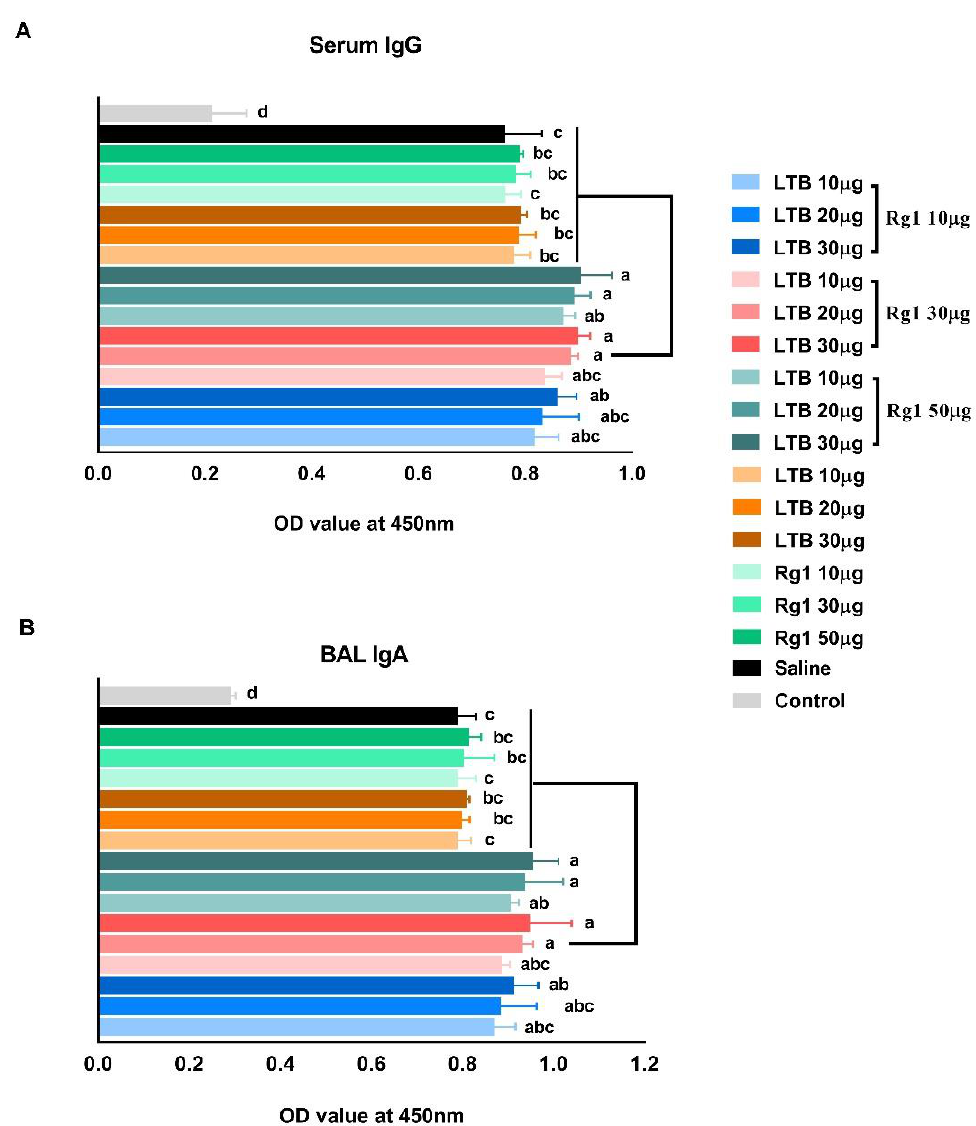
Figure 2. B subunit of Escherichia coli heat-labile enterotoxin (LTB-Rg1) increased porcine reproduc- tive and respiratory syndrome virus (PRRSV)-specific antibody responses. After anesthesia with isoflurane, mice ( n = 6/group) were intranasally immunized with an inactivated PRRSV vaccine (1 × 10 5 TCID 50 ) admixed with saline, LTB alone (10–30 µ g), Rg1 alone (10–50 µ g), or LTB (10–30 µ g) combined with Rg1 (10–50 µ g) on days 0, 7, and 21. Non-immunized mice served as negative controls. ( A ) Sera were collected on day 28 for IgG antibody analysis. ( B ) BAL fluid was collected on day 28 for IgA antibody analysis. Data are expressed as means ± SD. Different letters represent significant difference ( p < 0.05).